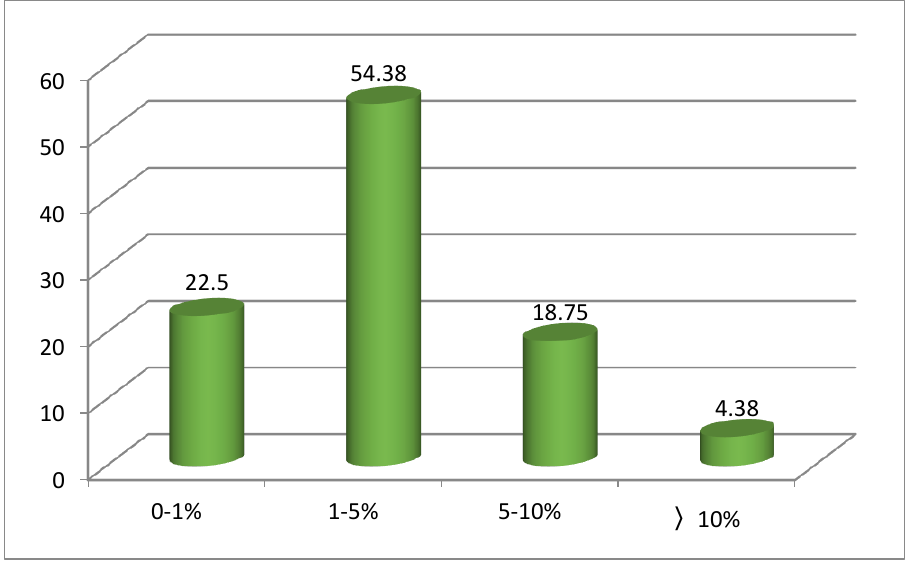
Figure 7. Percent of logEC 50 (AChE) values in different ARD% ranges of the ELM model.